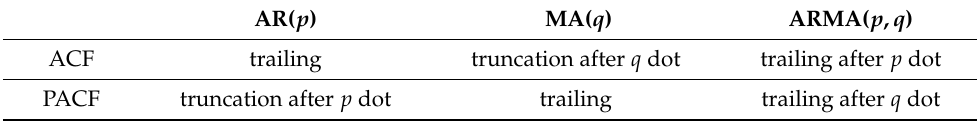
Table 1. Order estimation of the ARMA ( p , q ) model. AR( p ) MA( q ) ARMA( p , q ) ACF trailing truncation after q dot trailing after p dot PACF truncation after p dot trailing trailing after q